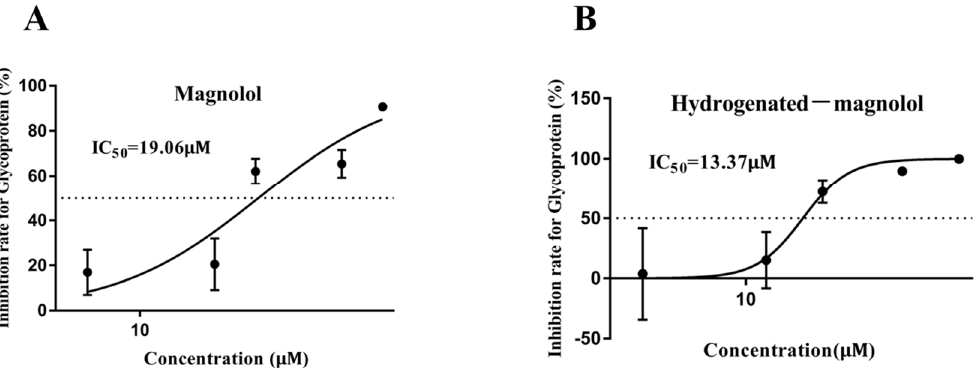
Figure 4. Dose–dependent effect of magnolol ( A ) and hydrogenated magnolol ( B ) against MSRV. The half–maximal inhibitory concentration (IC 50 ) is marked. The error bar indicates the SEM.